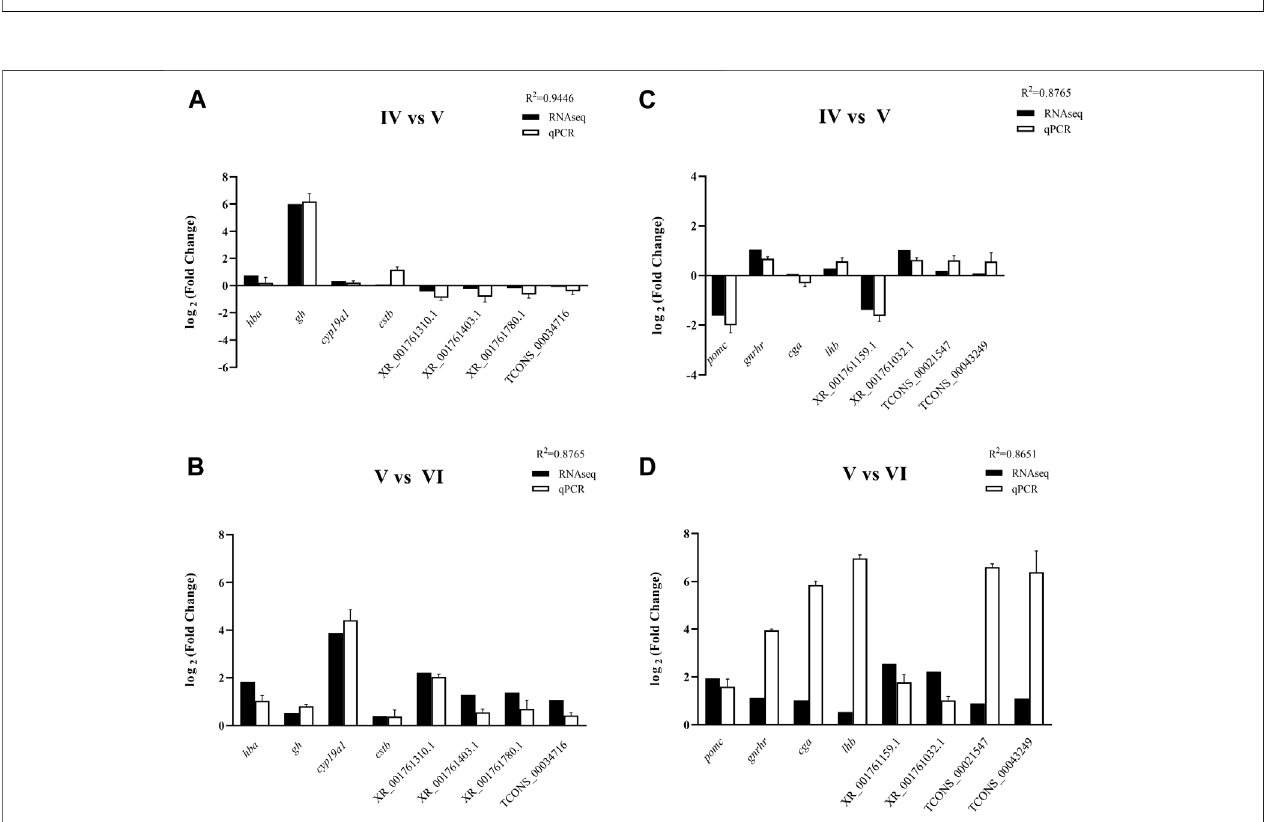
FIGURE7| RT-qPCRvalidationof4DEgenesand4DElncRNAsinthebrainoftonguesoleinovarianstagesIVvs.V (A) andstagesVvs.VI (B) andinthepituitary in ovarian stages IV vs. V (C) and stages V vs. VI (D) . The expression levels of the selected genes were normalized to the β -2-m gene.